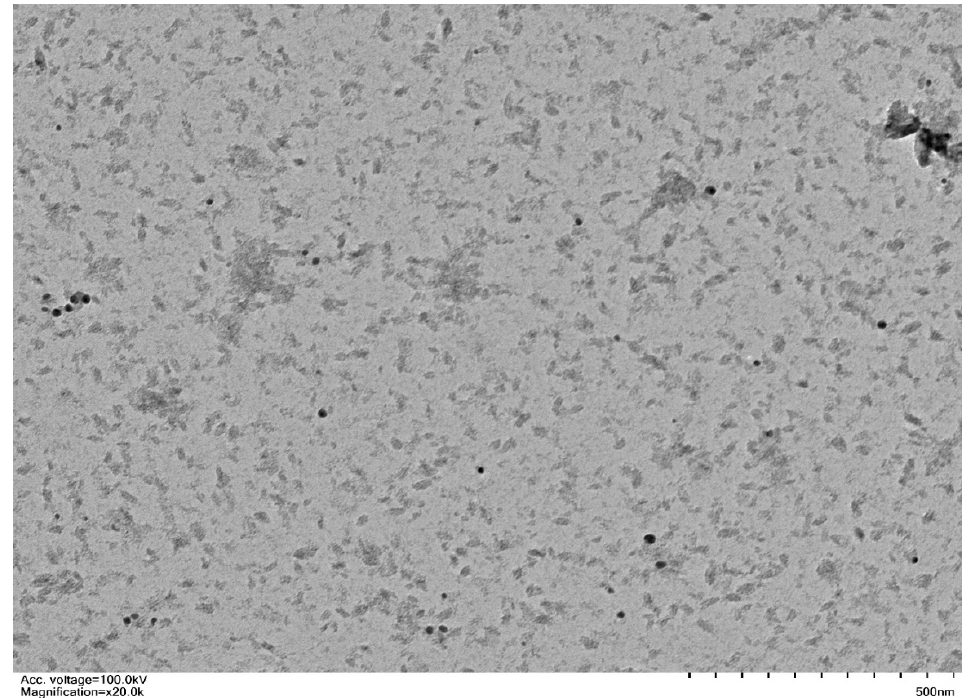
Figure 5. The HRTEM Images of CuONPs.